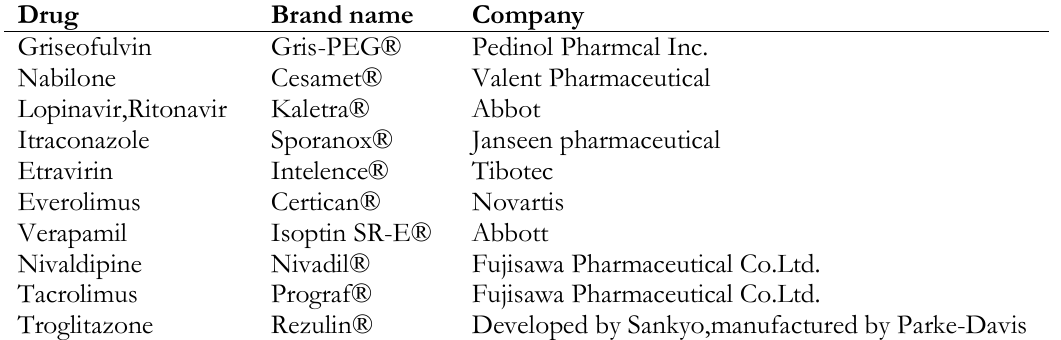
Table III. Commercially available solid dispersion